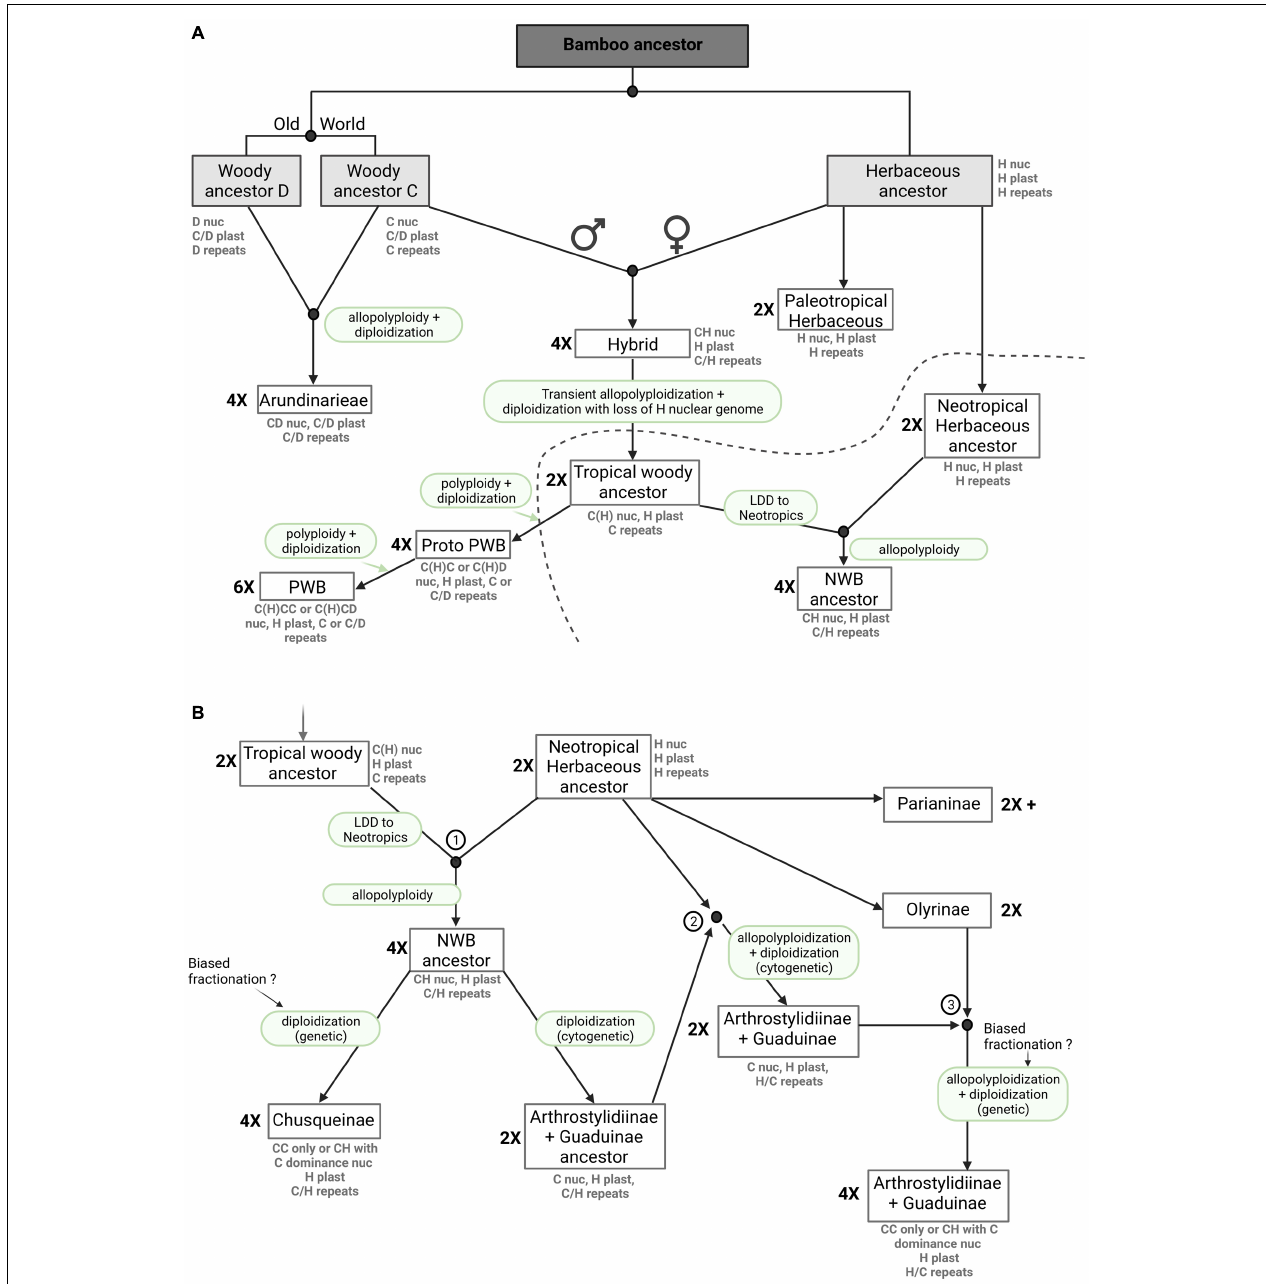
FIGURE 6 | Bamboo origins and evolution, a novel hypothesis. The presented figure depicts a model of bamboo origins and evolution that includes ancient hybridization, allopolyploidy, biased fractionation, genome dominance and diploidization. Nuclear and plastome genomes, as well as repeats (mobilomes, including TEs and other repeats) are presented for each extant clade. The ploidy level (2X, 4X, 6X) is indicated on the left side of the boxes. (A) Evolutionary hypothesis from the common bamboo ancestor to extant Arundinarieae, extant Paleotropical Woody Bamboos (PWB) and the Neotropical Woody Bamboo (NWB) ancestors. (B) Evolutionary hypothesis leading to the different extant NWB lineages after allopolyploidization between tropical woody and Neotropical herbaceous ancestors. The three encircled numbers match the three hybridization events denoted in Figure 4 . LDD means long distance dispersal.